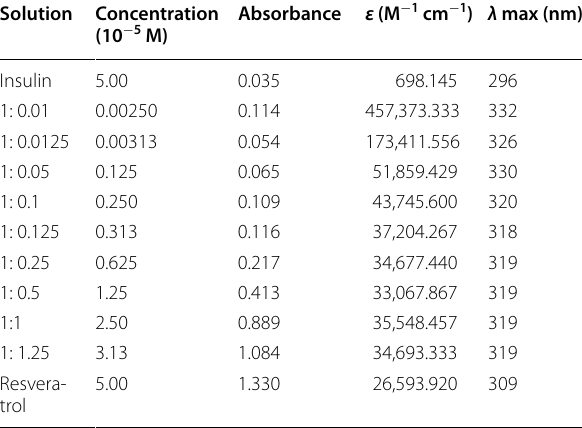
Table 2 Molar absorptivity and maximum absorbance of INS‑